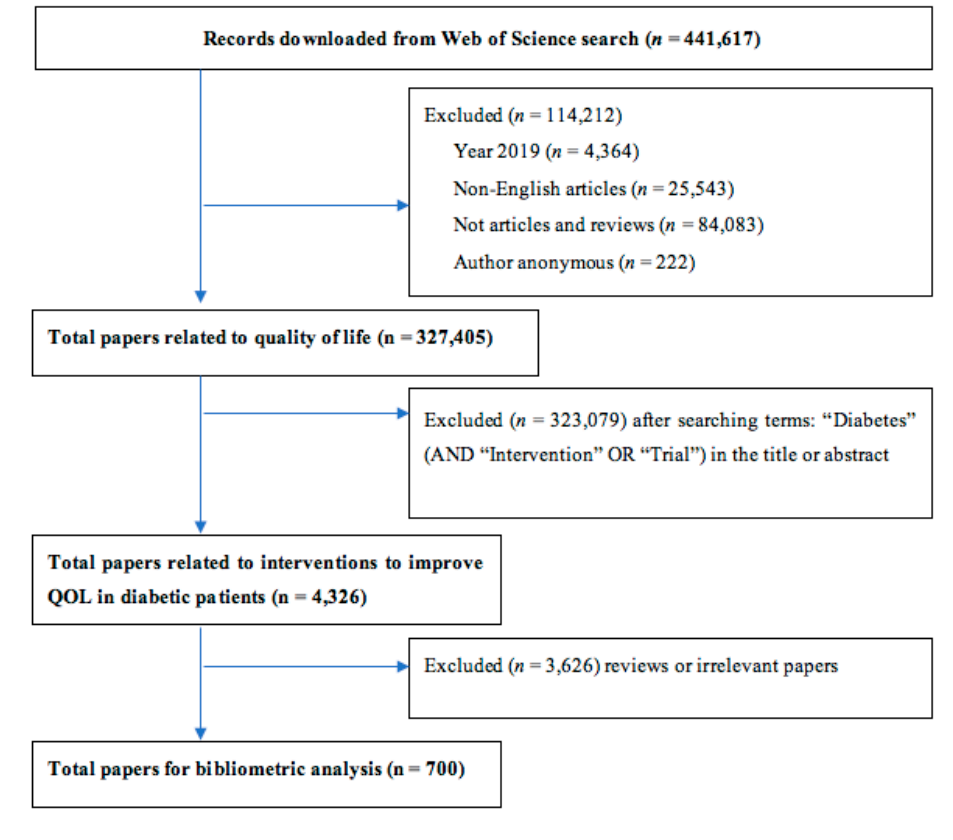
Figure 1. Selection of papers. Table 1. General characteristics of publications analyzed.